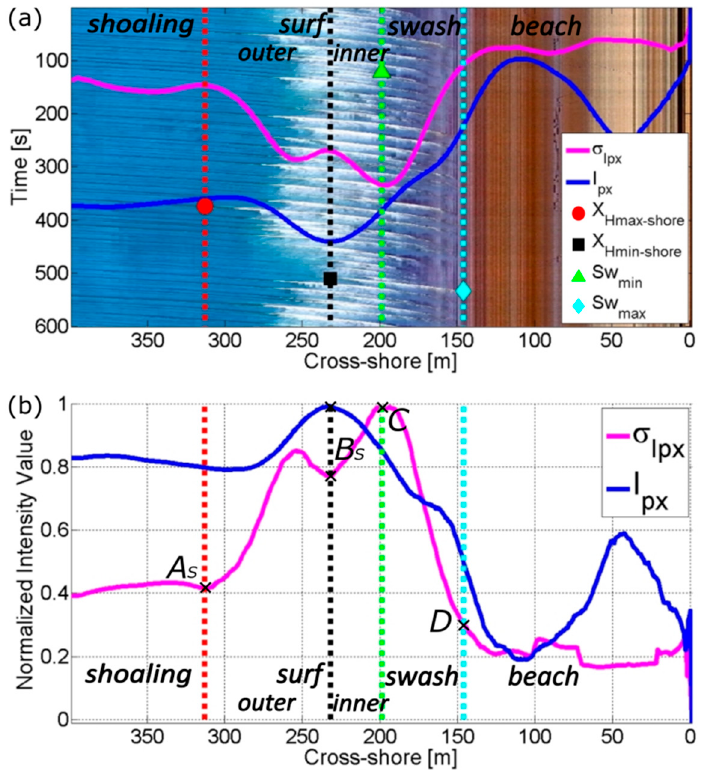
Figure 5. Timestack pixel intensity statistics combined with wave transformation domains at Ribeira d’Ilhas. ( a ) Wave transformation domains superimposed on Timestack combined with I px and σ I. Dashed colored lines identify the boundaries between wave domains. ( b ) Min–Max I px (blue line) and σ I px (magenta) plotted together with wave transformation regions boundaries. The specific points on the signal coinciding with wave domain boundaries are indicated with related name and by black crosses (Table 1). Dashed colored lines identify the boundaries between wave domains.